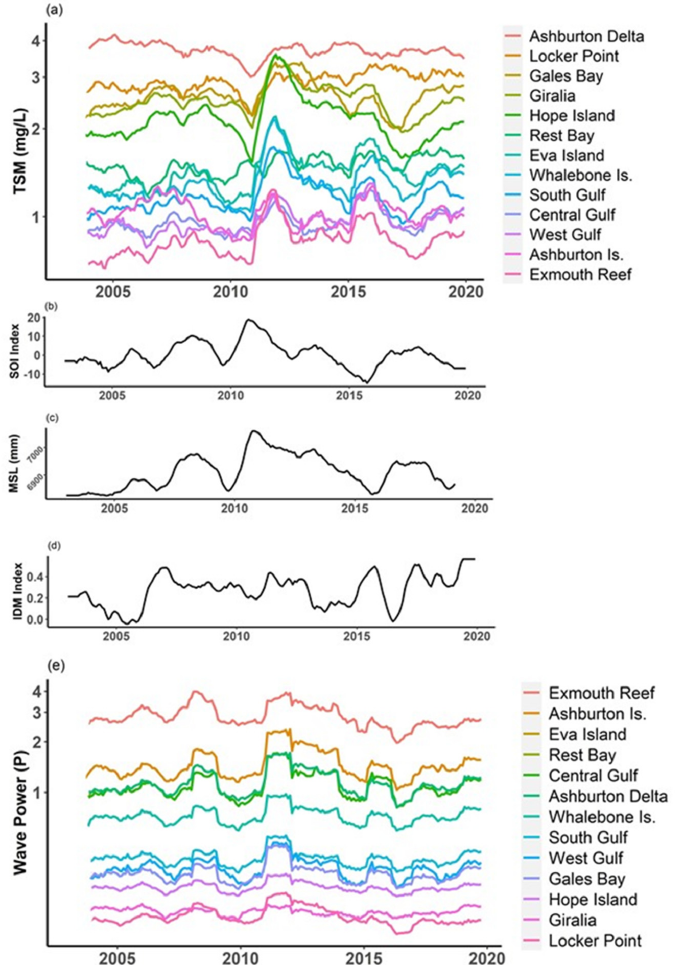
Figure 7. The 12-month rolling mean of ( a ) turbidity (TSM) at 13 locations in the Exmouth Gulf; ( b ) El Niño-Southern Oscillation Index (SOI); ( c ) mean sea level, ( d ) Indian Ocean Dipole mode (IDM), and ( e ) wave power at 13 locations in the Exmouth Gulf.